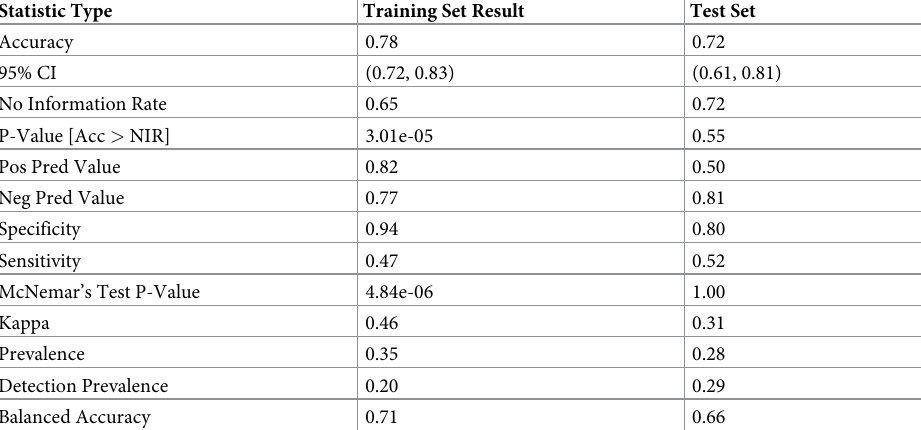
Table 5. Confusion matrix statistics for random forest (RF) training ( n = 241) and test sets ( n =